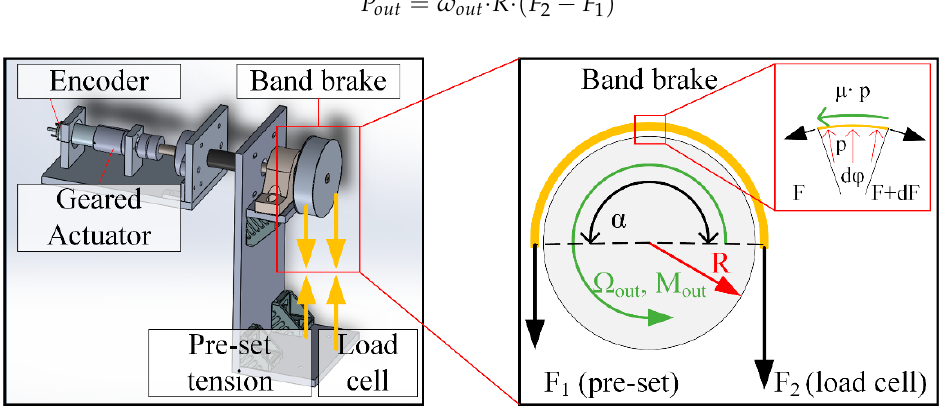
Figure 4. Dynamometer based on Euler–Eytelwein theory for band brakes.